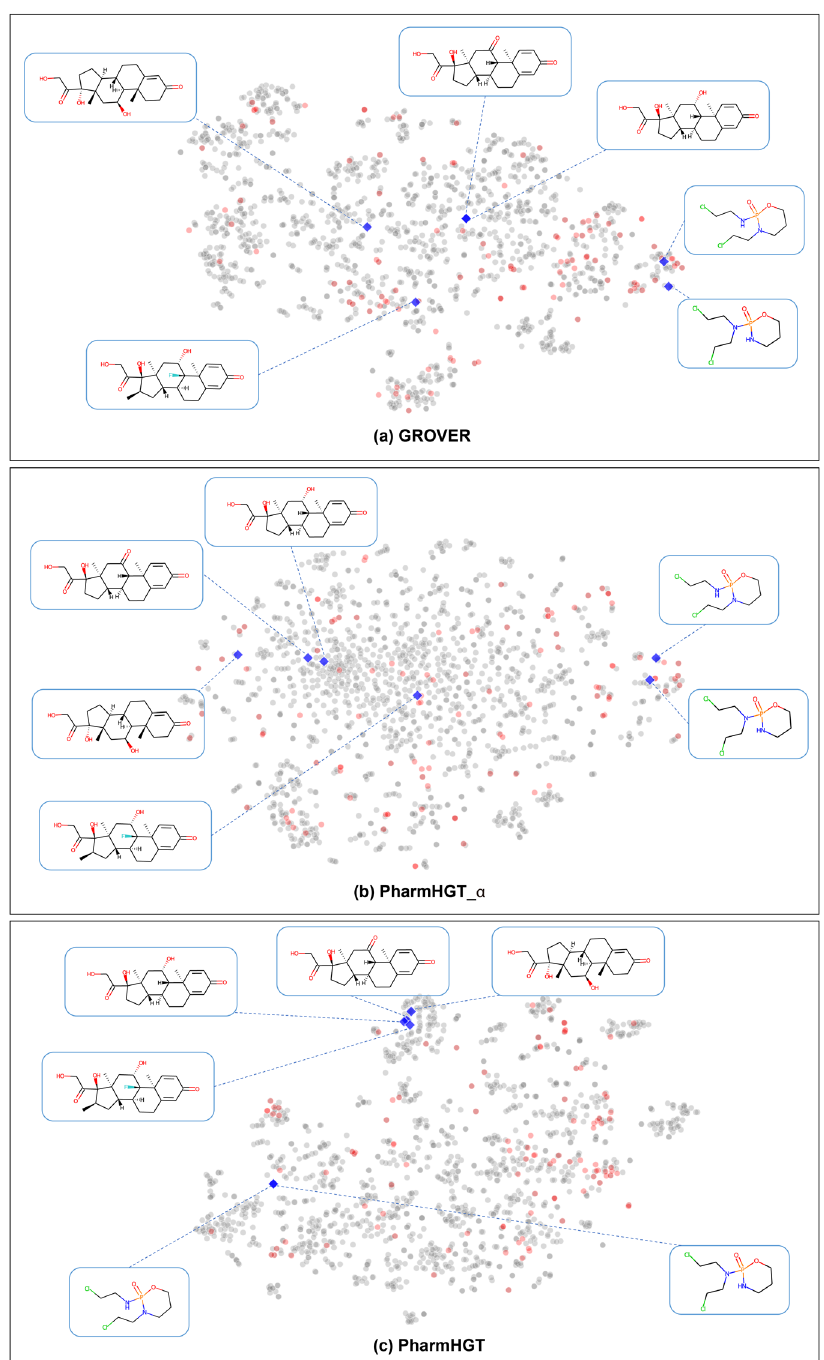
Fig. 5 Case study. Case study by t-SNE visualization of molecular features on ClinTox dataset from a GROVER, b PharmHGT_ α , and c PharmHGT. Where molecular with toxicity are colored in gray, non-toxic molecules are in red and blue indicating six molecules are selected for the case study that showed toxicity in clinical trials and is still toxic after